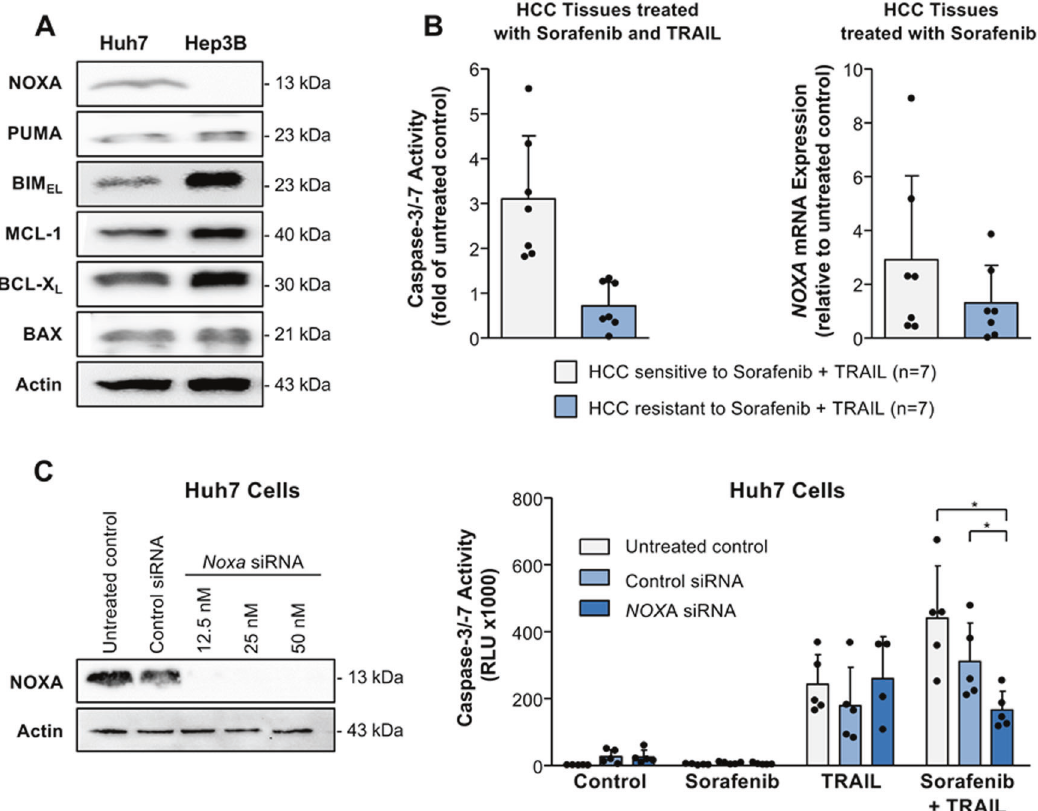
Fig. 2 NOXA expression determines apoptosis sensitivity (caspase activation) to sorafenib/TRAIL in Huh7 cells and human HCC tissues. A Expression of pro- (NOXA, PUMA, BIM, and BAX) and anti-apoptotic (MCL-1, BCL-X L ) Bcl-2 proteins in the HCC cell lines Huh7 and Hep3B as detected by Western blotting. In contrast to Huh7 cells, NOXA expression was undetectable in Hep3B cells. B HCC tissues from different patients ( n = 14) were treated for 8 h with sorafenib (7.5 µg/ml) and TRAIL (50 ng/ml; left panel). In contrast to apoptosis-resistant HCC tissues ( n = 7), in apoptosis-sensitive tissues ( n = 7) treatment with sorafenib and TRAIL resulted in caspase-3/-7 activation. HCC tissues from the same patients were treated for 8 h with sorafenib (right panel). Sorafenib induced a stronger upregulation of transcripts encoding the BH3-only protein NOXA (assessed by real-time PCR) in HCC tissues sensitive to sorafenib/TRAIL-induced apoptosis ( n = 7), compared to HCC tissues resistant to this treatment combination ( n = 7). C Effective siRNA-mediated NOXA downregulation in Huh7 cells as determined by Western blotting (left panel). Downregulation of NOXA by siRNA (12.5 nM) did not affect caspase activation in Huh-7 cells treated for 8 h with sorafenib or TRAIL alone. In contrast, caspase activation induced by the combination of sorafenib and TRAIL was signi fi cantly reduced in Huh7 cells with NOXA downregulation as compared to the respective control cells. The results of fi ve independent experiments are shown. * p <